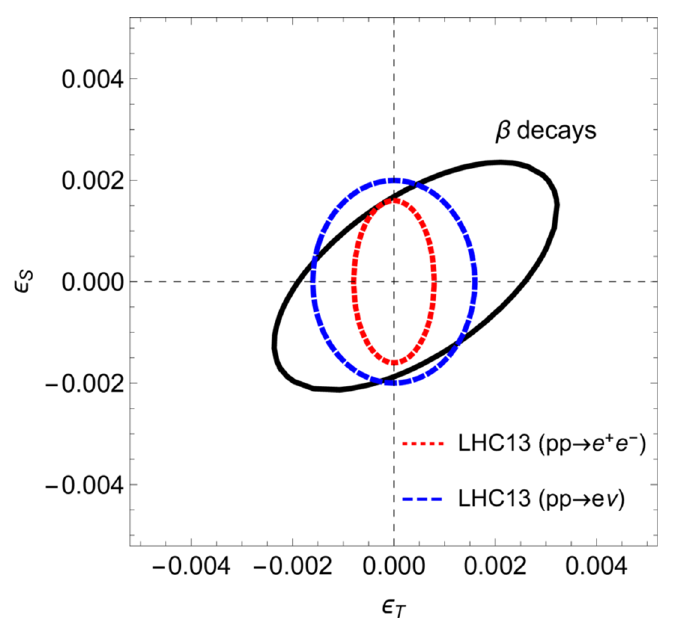
Figure 3 . 90% CL constraints on scalar and tensor coefficients obtained from beta decays in this work (solid black line) and from LHC data (dashed blue and dotted red lines) [22]. We stress here again that (cid:15) is defined in this work with a different normalization (by a factor of 4) than in ref. T